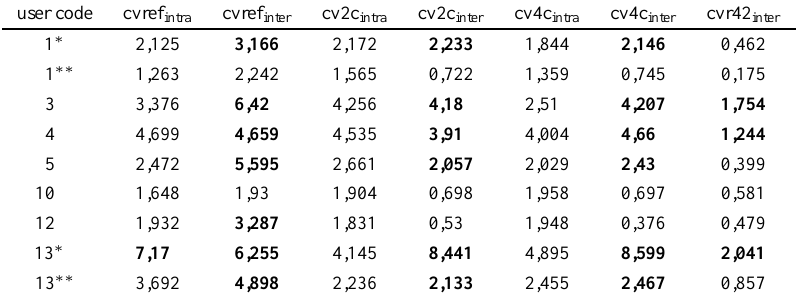
Quality control variables of the QC-DNA test for different users